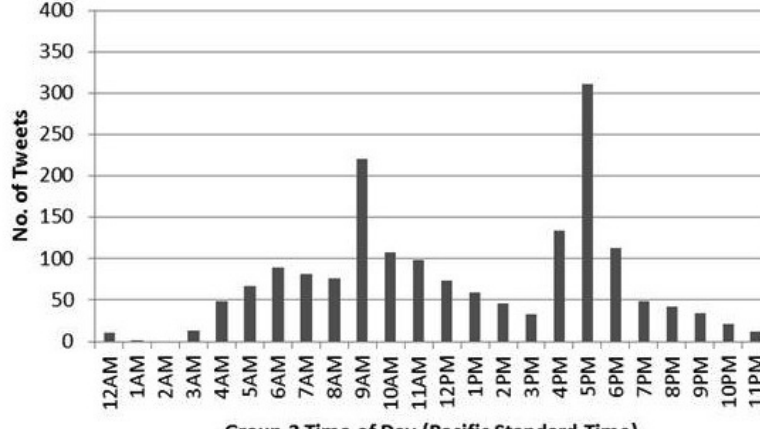
Figure 4. Tweeting by time of day in Group